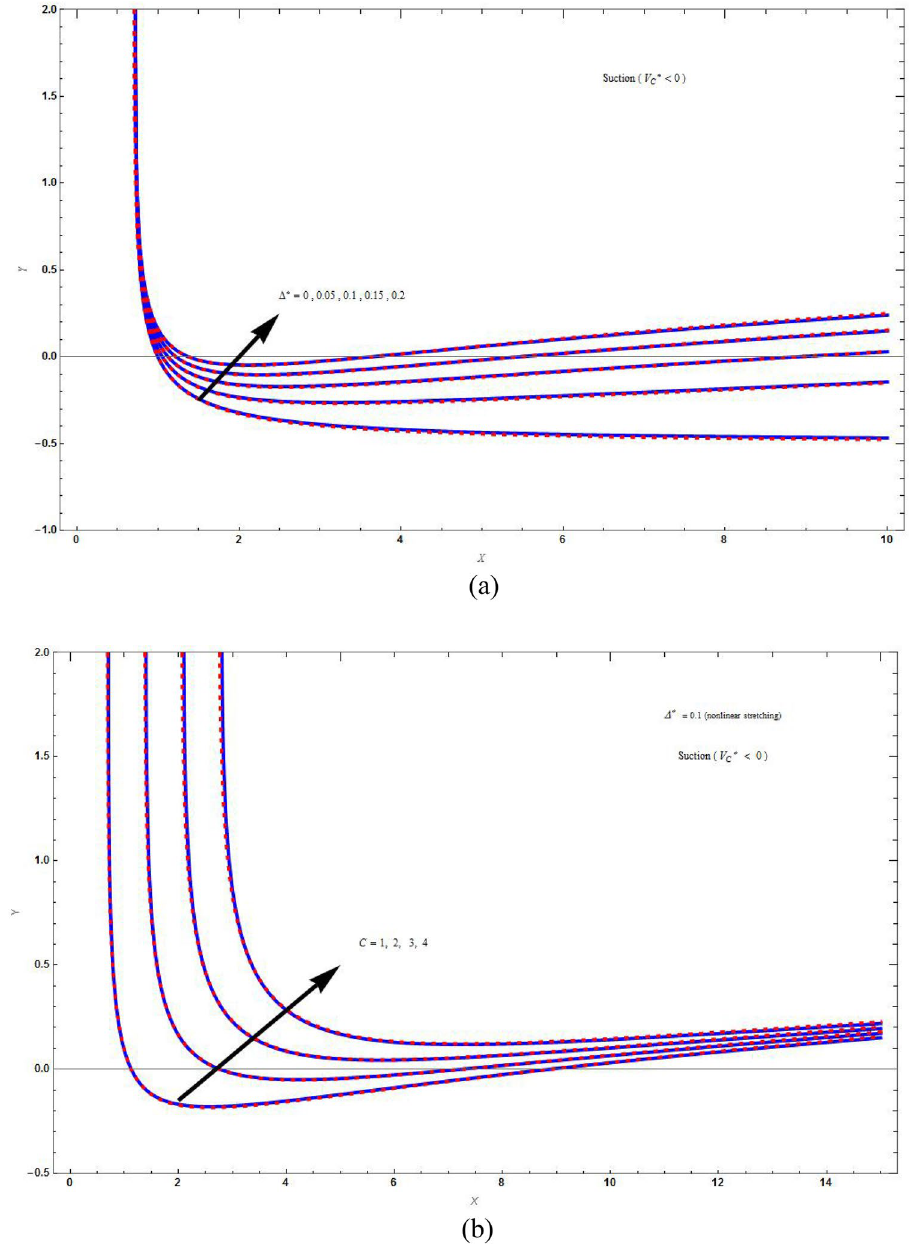
C for suction boundary by varying ( a ) superlinear parameter (� Figure 3. The streamline plot ψ( X , Y ) = 1 , K 2 , and ( b ) values of C with M 1 . Blue solid lines are for the base fluid C K (cid:31) (cid:31) with M = = = = = = = Al 2 O 3 / water and red dotted lines denotes the hybrid nanofluid Cu −